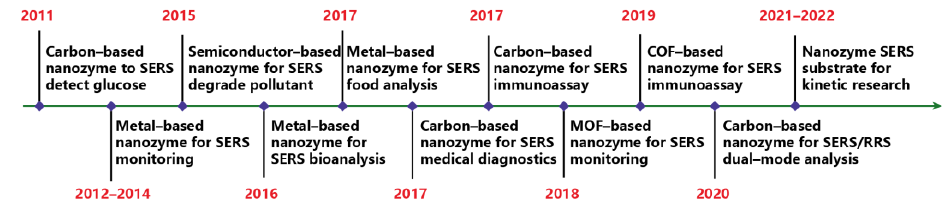
Figure 2. The development of nanozymes in SERS.